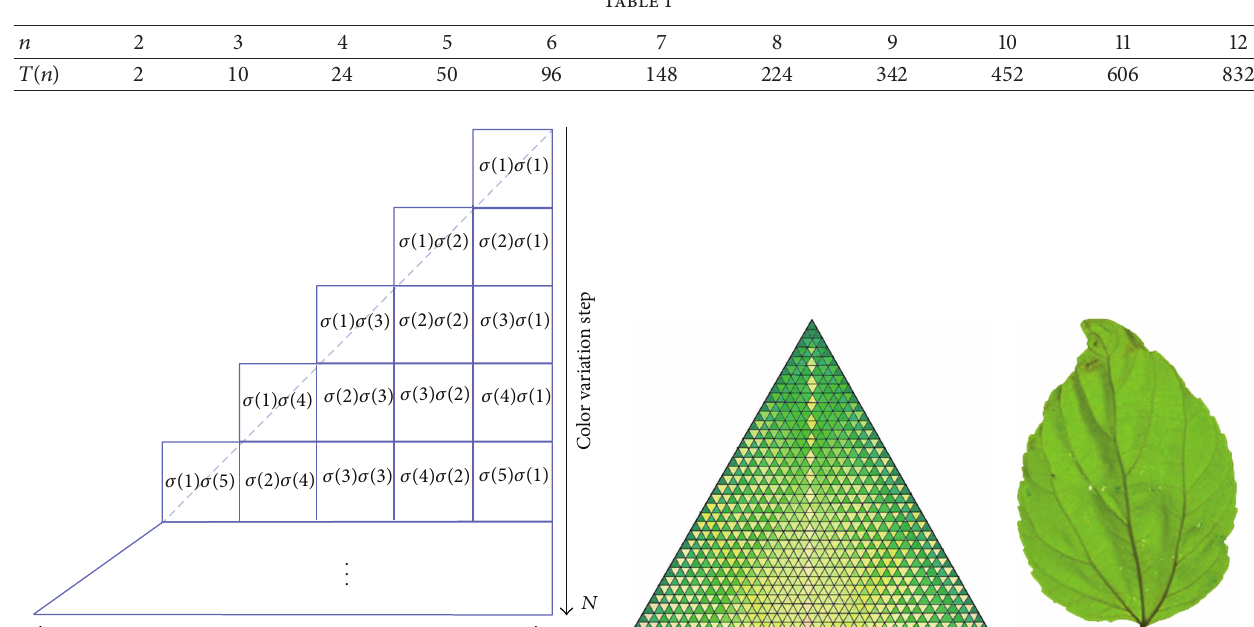
“ 𝑖𝑑𝑥 ” and the corresponding color “ 𝑐 𝑖𝑑𝑥 𝑑 ” in the color table color in 𝑖 th row and 𝑗 th column [13]. Figure 2 represents the image of a color table set created by calculating the color